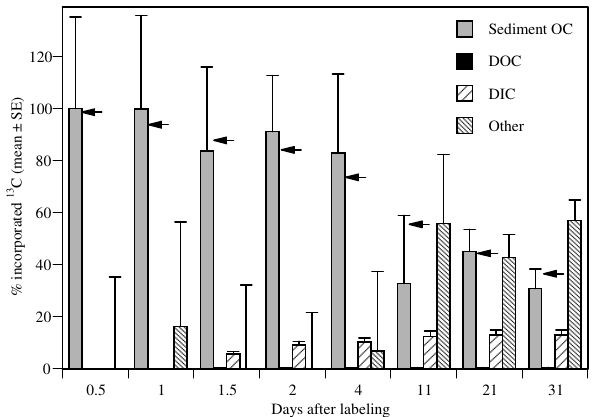
Fig. 3. Carbon budget showing cumulative percentage (mean ± SE, n = 2) of the 13 C that was initially incorporated by microphyto- benthos that remained in total sediment organic carbon (0–10cm depth) and that had been lost via dissolved organic carbon and dis- solved inorganic carbon or via unknown pathways since the end of 13 C-labeling. Note that fluxes of CO 2 were too low to be shown. Arrows indicate 13 C expected to remain in total sediment organic carbon at each sampling time, based on 2-G modeling. Days after labeling indicate time of sample collection, including time required for core